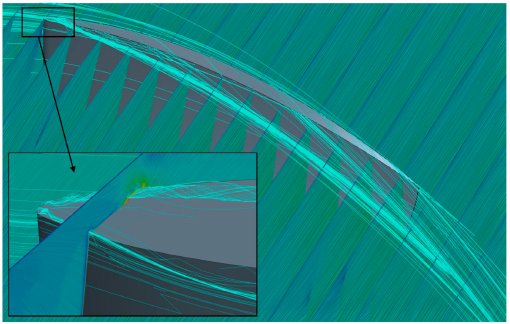
Figure 11. The streamlines around a blade tip. Q = 0.42 m 3 /s.